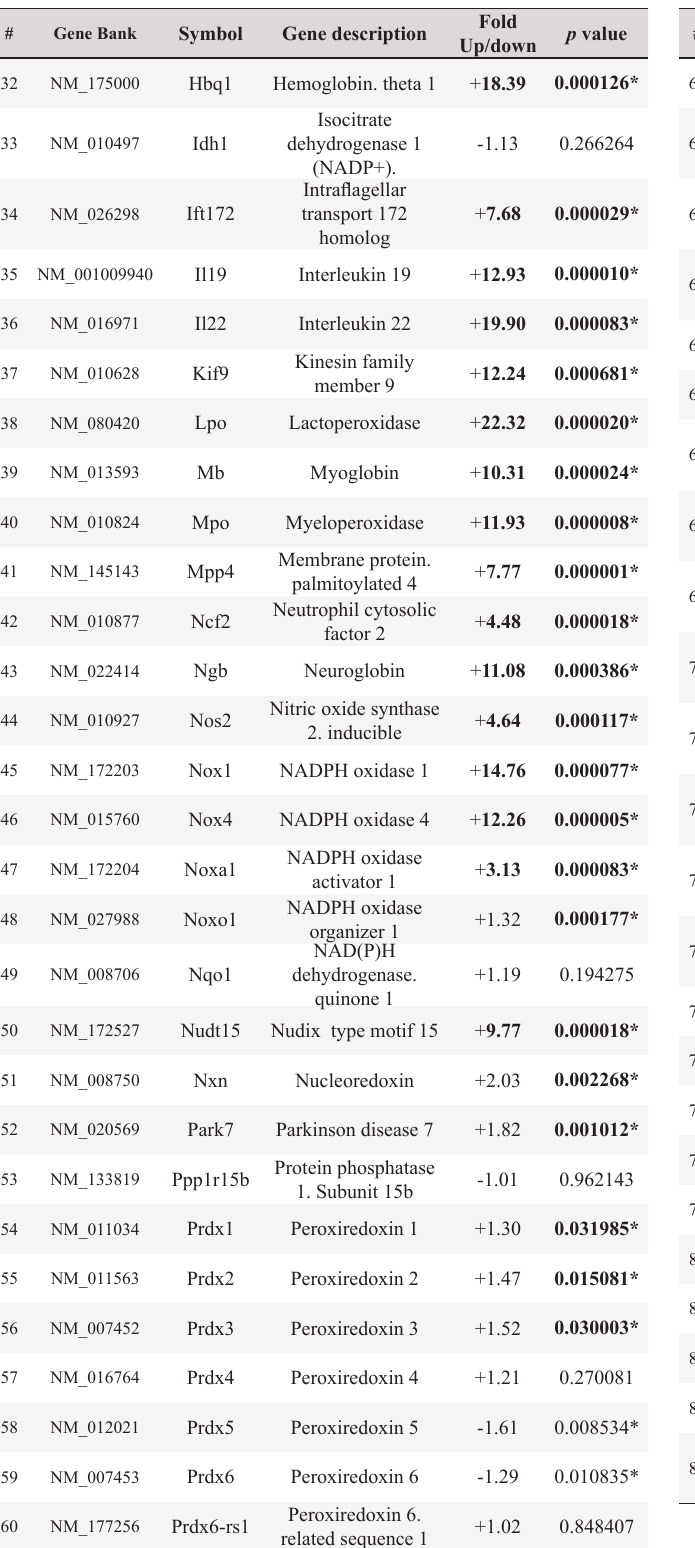
TABLE 2 - Alphabetical sequence of genes investigated TABLE 3 - Alphabetical sequence of genes investigated and the fold up (+) or down (-) regulation (Bold=up-regulation/ and the fold up (+) or down (-) regulation threefold). ( Student’s t-test). (*=significant value p<0.05).